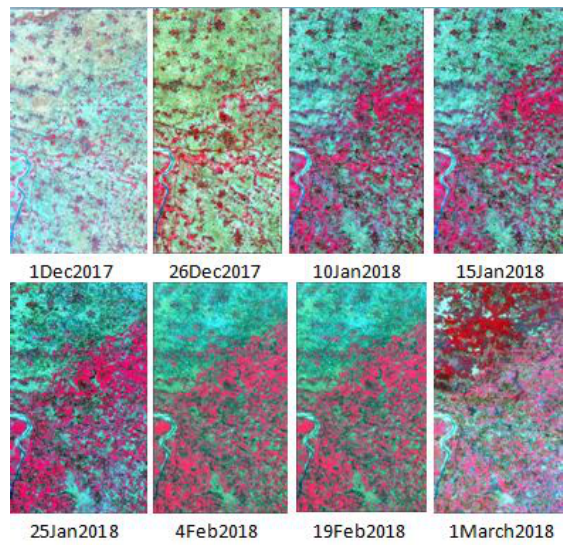
Figure 5. Spatio-Temporal changes of vegetation in